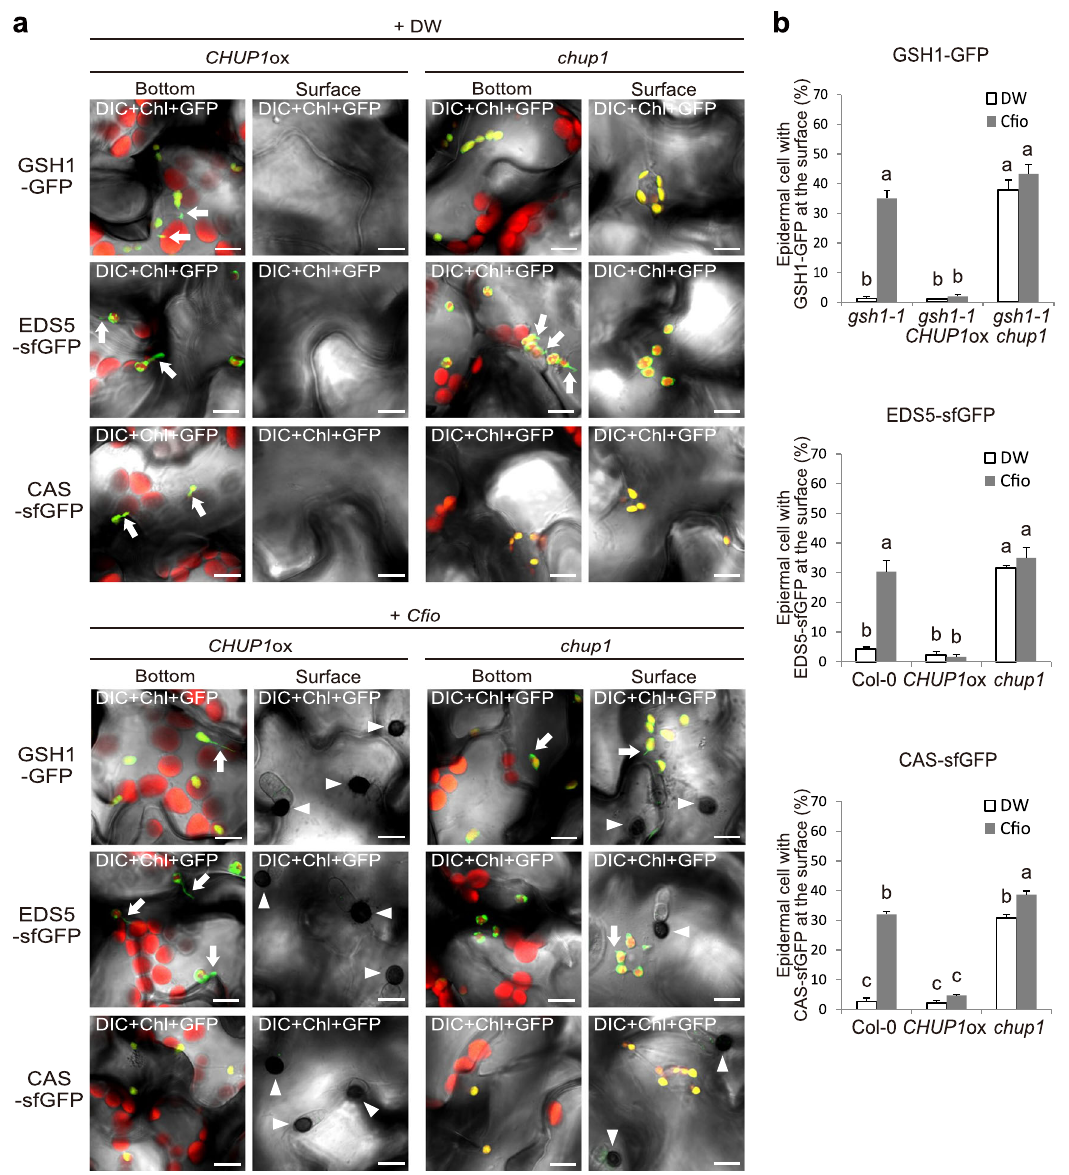
Fig. 6 Localization pattern of GSH1, EDS5, and CAS tightly linked to epidermal chloroplasts and the ECR. a Localization pattern of GSH1, EDS5, and CAS proteins in CHUP1 ox and chup1 plants. The transgenic gsh1 CHUP1 ox and gsh1 chup1 plants expressing GSH1-GFP under its own promoter, and CHUP1 ox and chup1 plants expressing EDS5-sfGFP and CAS-sfGFP under the CaMV 35S promoter were incubated with C fi o and observed at 2 dpi. DW was used as a control. The chloroplasts were visualized based on chlorophyll auto fl uorescence. The white arrowheads and arrows indicate melanized appressoria and stromules, respectively. Scale bar, 10 µ m. b Quanti fi cation of epidermal cells with surface fl uorescence of GFP/sfGFP-labeled immune components. C fi o - inoculated cotyledons of the indicated Arabidopsis were analyzed at 2 dpi. A total of 100 cells in contact with the melanized appressorium were observed. As a control, DW was spotted. The means and SE were calculated from three independent plants. Means not sharing the same letter are signi fi cantly different ( P < 0.05, two-way ANOVA with Tukey ’ s HSD